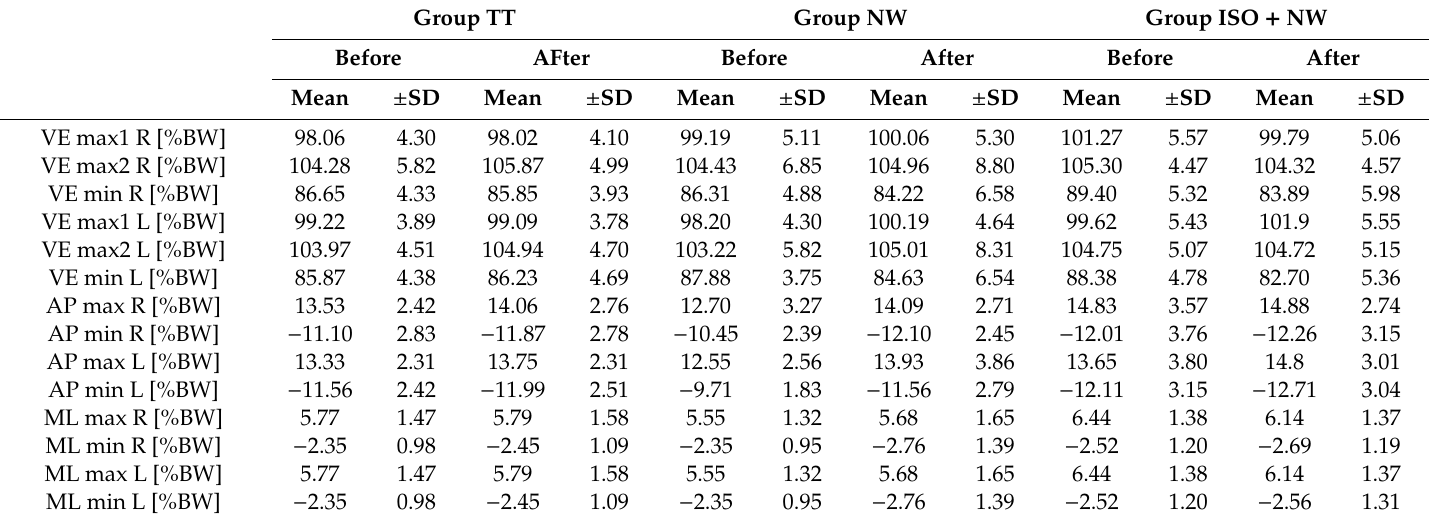
Table 6. The values of the ground reaction forces recorded in each group of subjects before and after the 3-month training program. Group TT Group NW Group ISO + NW